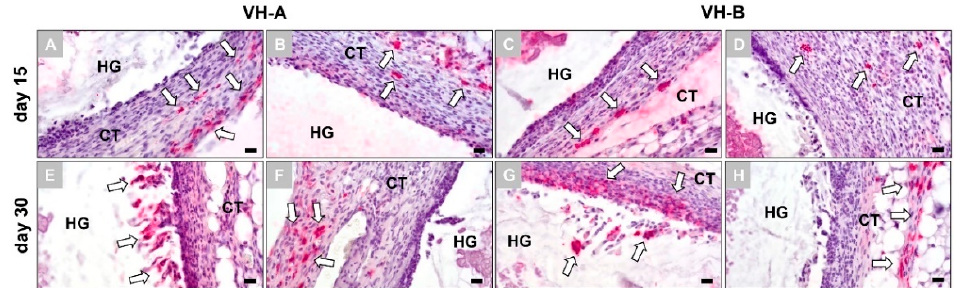
Figure 3. Immunohistochemical detection of pro- and anti-inflammatory macrophage subtypes at 15 and 30 days post implantation. ( A ) VH-A hydrogel at day 15, M1 immunostaining. ( B ) VH-A hydrogel at day 15, M2 immunostaining. ( C ) VH-B hydrogel at day 15, M1 immunostaining. ( D ) VH-B hydrogel at day 15, M2 immunohistochemical staining. ( E ) VH-A hydrogel at day 30, M1 immunostaining. ( F ) VH-A hydrogel at day 30, M2 immunostaining. ( G ) VH-B hydrogel at day 30, M1 immunostaining. ( H ) VH-B hydrogel at day 30, M2 immunostaining. White arrows: immuno- histochemically stained macrophages, HG: hydrogel, CT: connective tissue (CD11c and CD163 im- munostainings, magnification = 400 × , scalebars = 20